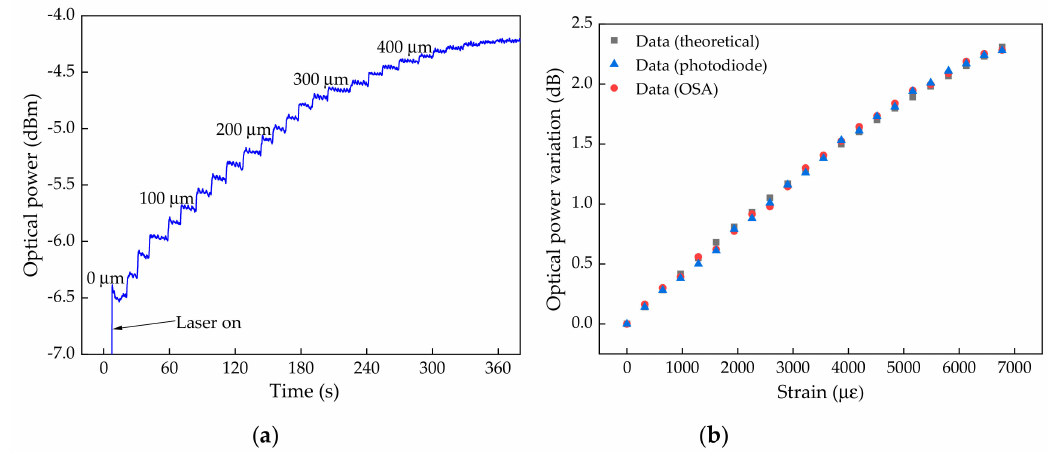
Figure 9. ( a ) Optical power values over a long time, obtained with the photodiode in the proposed architecture; ( b ) Optical power variation obtained theoretically and experimentally (photodiode and OSA) as a function of the strain